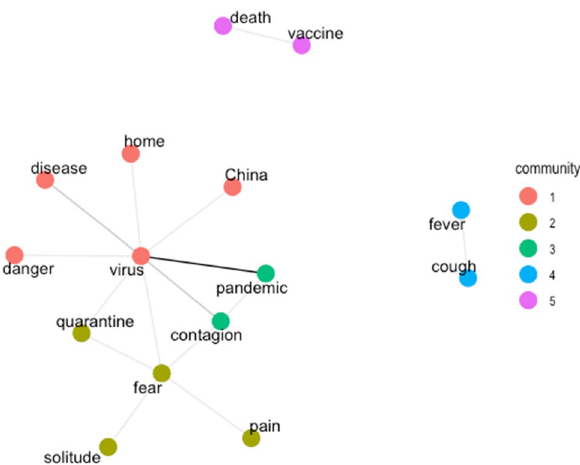
Figure 1. Network of words (translated in English) produced by participants in relation to COVID-19 . Thicker links represent words that were most frequently produced